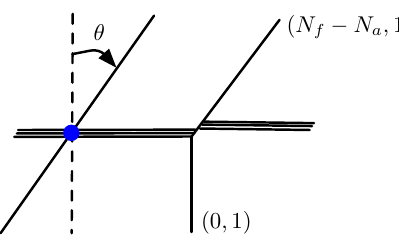
Figure 3 . The angle θ is between the dash line (parallel to the (0,1)-brane) and the ( N f − N a , 1) - brane. The blue node denotes the D3-brane that is along the direction perpendicular to 5-branes webs.